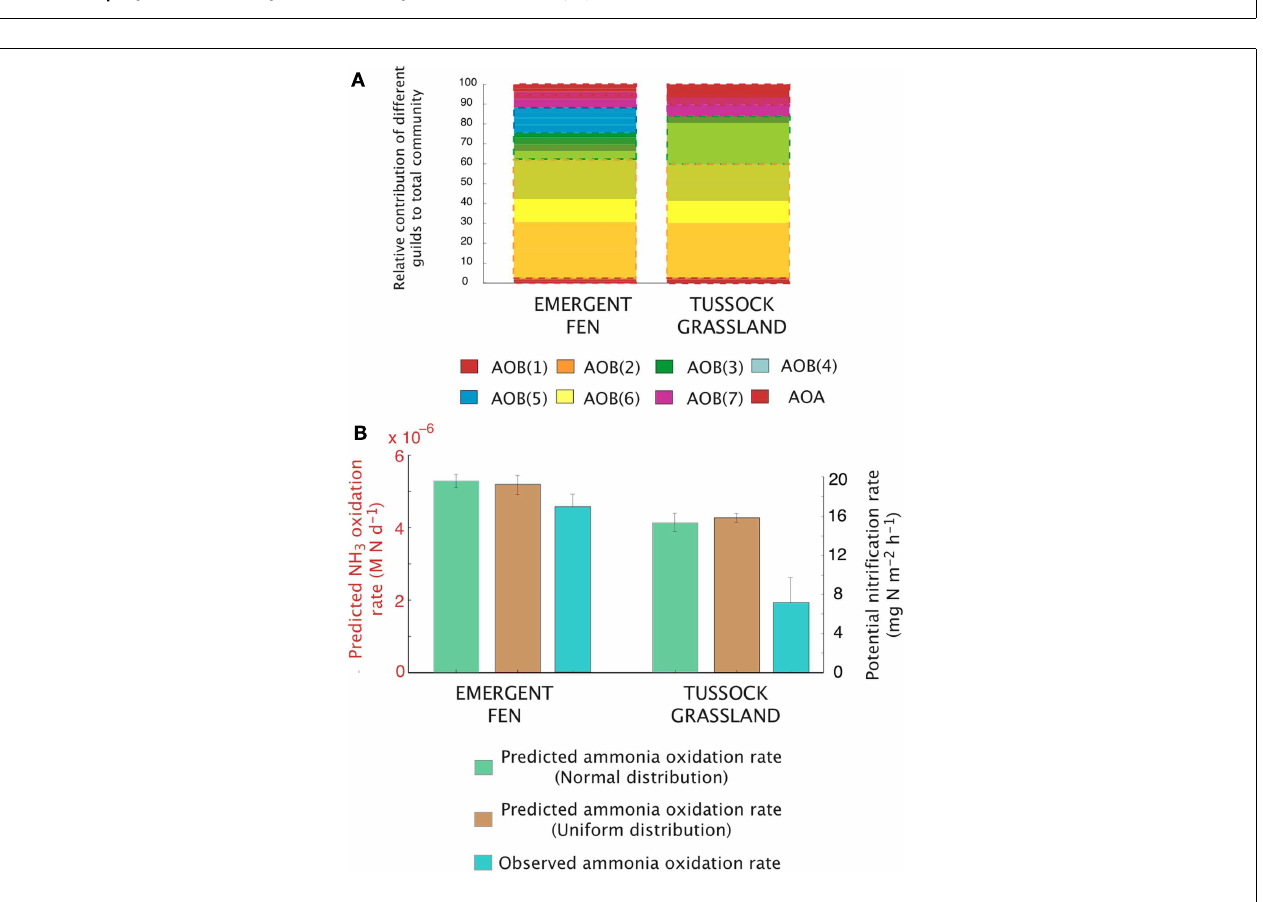
FIGUREA4 | Simulations of the activity and diversity ofAOB communities in high-latitude ecosystems. (A) Simulations of multiple AOB analogs ( n = 5 analogs per guild) across the different sites.These simulations are based on a normalized distribution of trait values. Each guild is represented by a distinct color. Subtle differences in the shade of that color